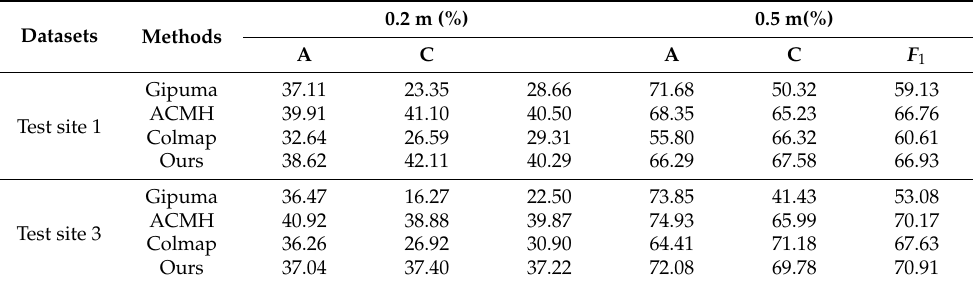
Table 4. The precision comparison of point clouds with different methods in test site 1 and test site 3 of the Vaihigen dataset. The accuracy (A), completeness (C), and F 1 score (in %) are evaluated with 0.2 m and 0.5 m